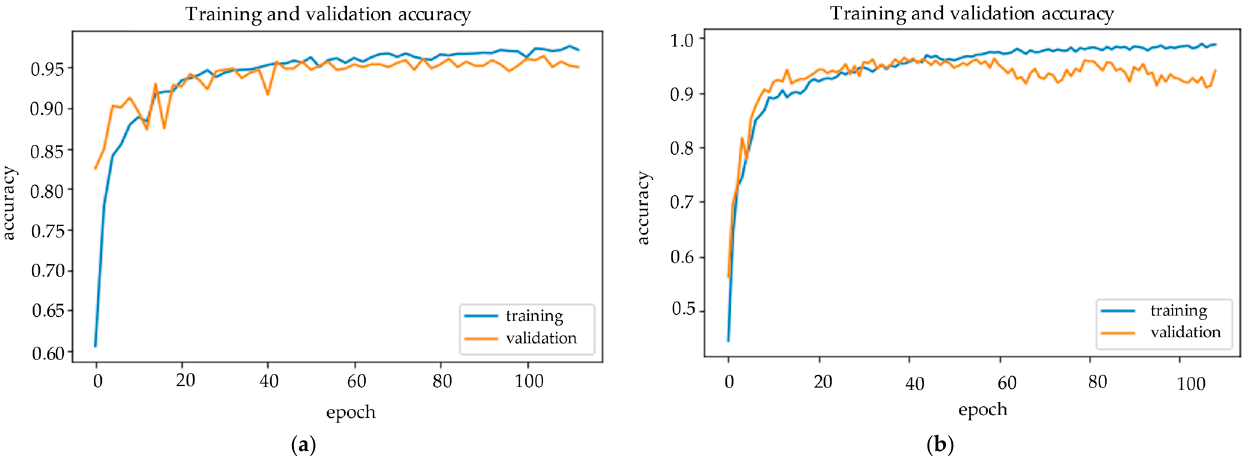
Figure 7. Training history of ( a ) DenseNet and ( b ) Hybrid EfficientNet-DOLG on the COVID-19 classification task.